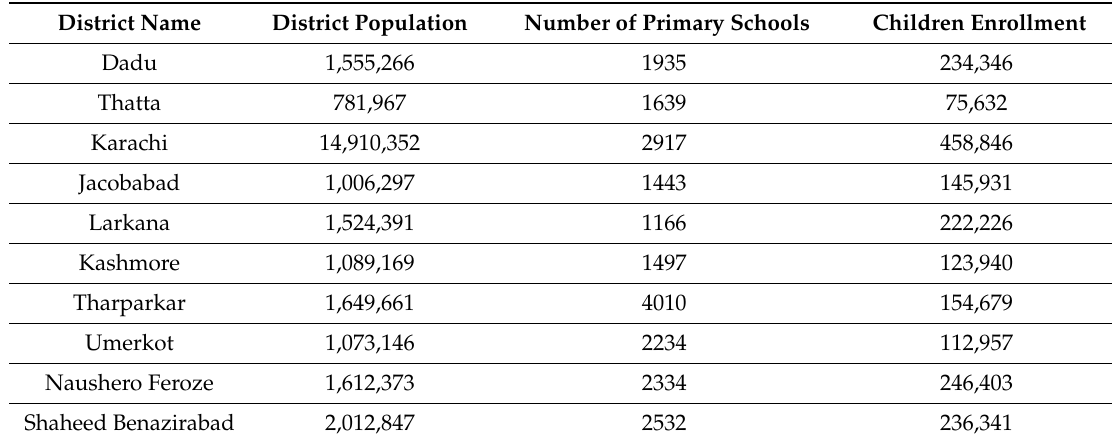
Table A1. Demographic characteristics of study